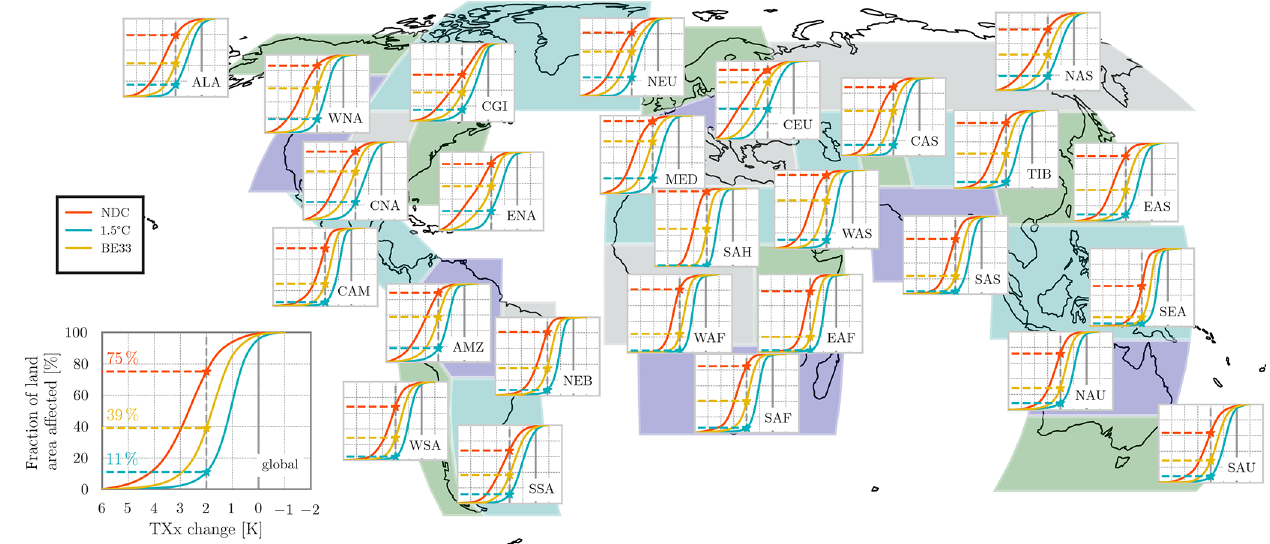
Figure 3. Changes in hot extremes (TXx) in the period 2081–2100 relative to 1986–2006 for the NDC scenario (red), the BE33 scenario (yellow) and the 1.5 ◦ C scenario (cyan). Changes are presented as land area fraction ( y axis) affected by changes in TXx ( x axis) for 26 world regions and globally. Cumulative distributions are based on an area-weighted aggregation of all TXx change values projected at grid cells within a region and across climate models. A vertical dashed grey line indicates TXx changes of 2 ◦ C. The asterisks and the horizontal lines going from the 2 ◦ C line to the left y axis show the land fraction that is affected by an increase in TXx of at least 2 ◦ C.